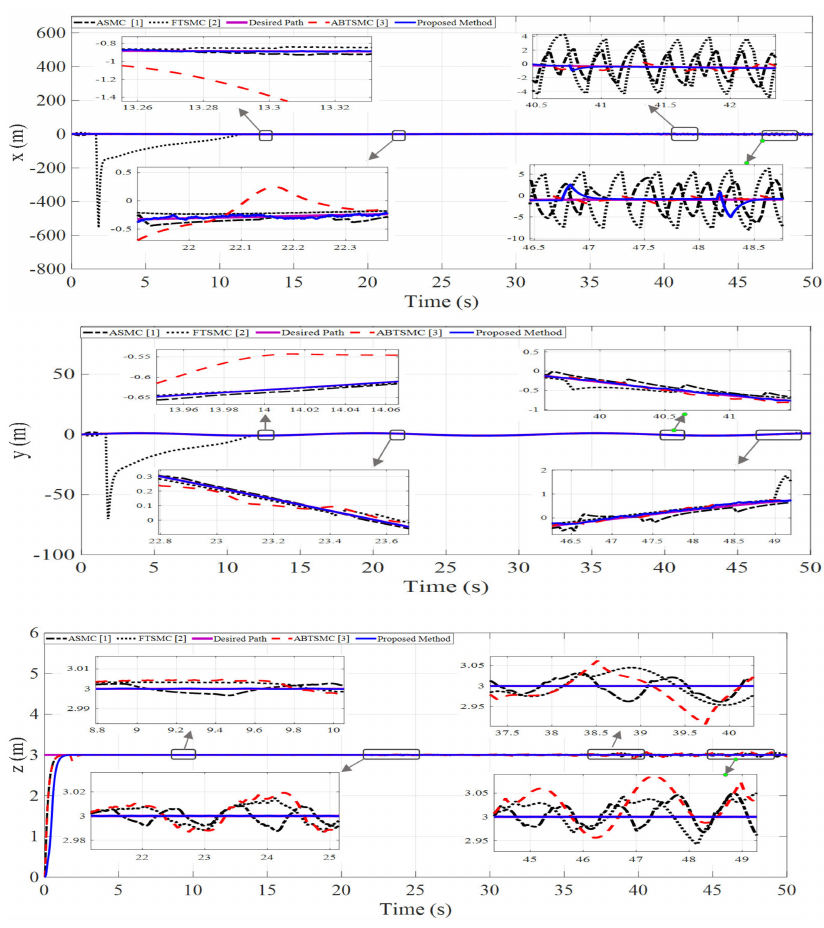
Figure 6. Quadrotor position under 50% step fault to actuators 1 and 2.